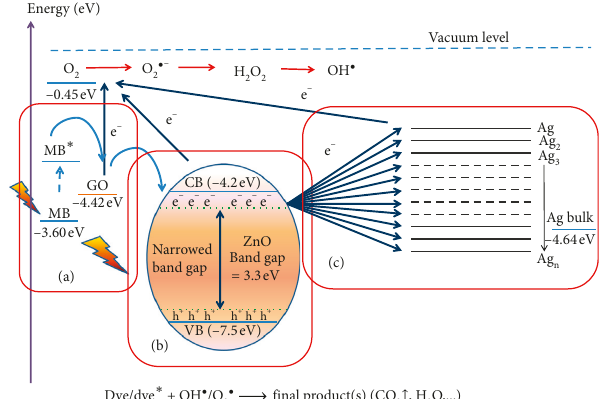
Figure 12: Proposed mechanism for MB removal using synthesized